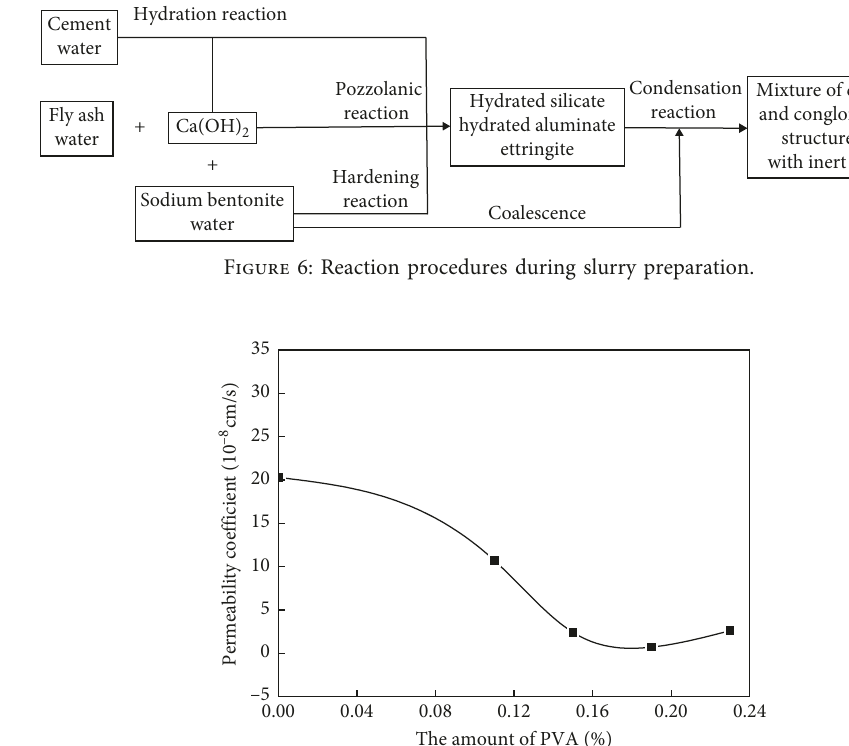
Figure 7: 28-day Permeability coefficient with different amounts of PVA. Table 9: Output leachate pollutant concentrations.